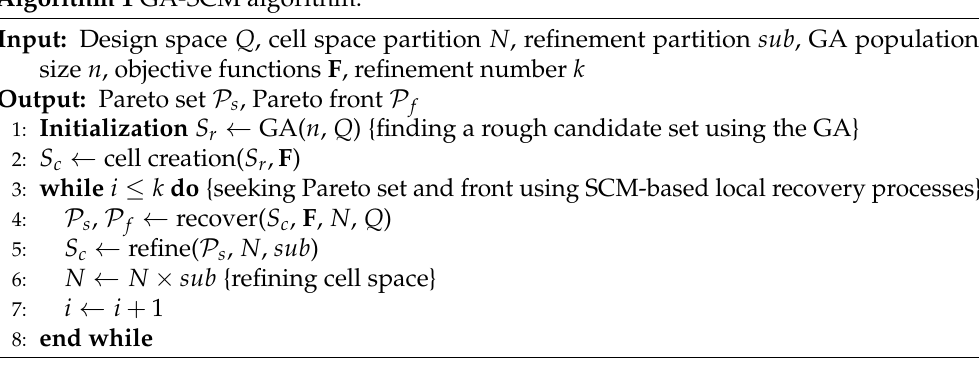
Algorithm 2 SCM-based recovering algorithm.